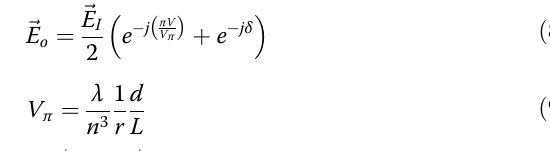
delay ( τ = R7C2) and a comparator (U4). This pulse opens